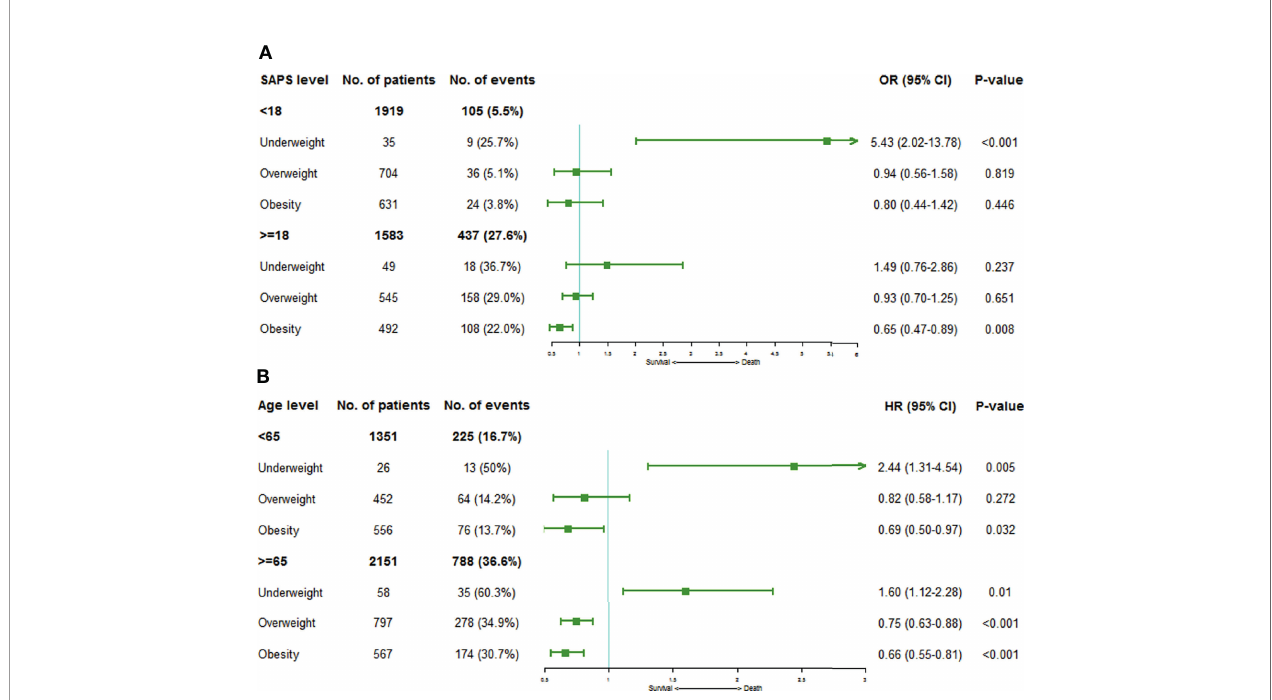
FIGURE 4 | Forest plots depicting the ORs or HRs of mortality risks on the strati fi cation of SAPS and age levels by BMI category. (A) shows ORs of 30-day mortality strati fi ed by SAPS levels, and (B) demonstrates HRs of 1-year mortality on the strati fi cation of age levels. Squares represent ORs or HRs with 95% CIs demonstrated as horizontal bars. Normal weight category acts as the reference